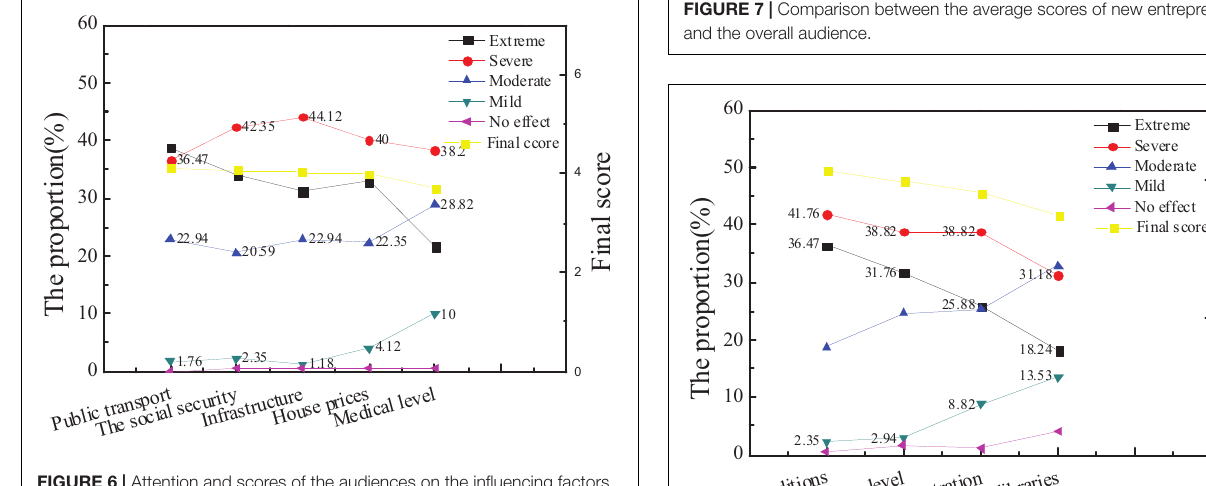
FIGURE 7 | Comparison between the average scores of new entrepreneurs and the overall audience.